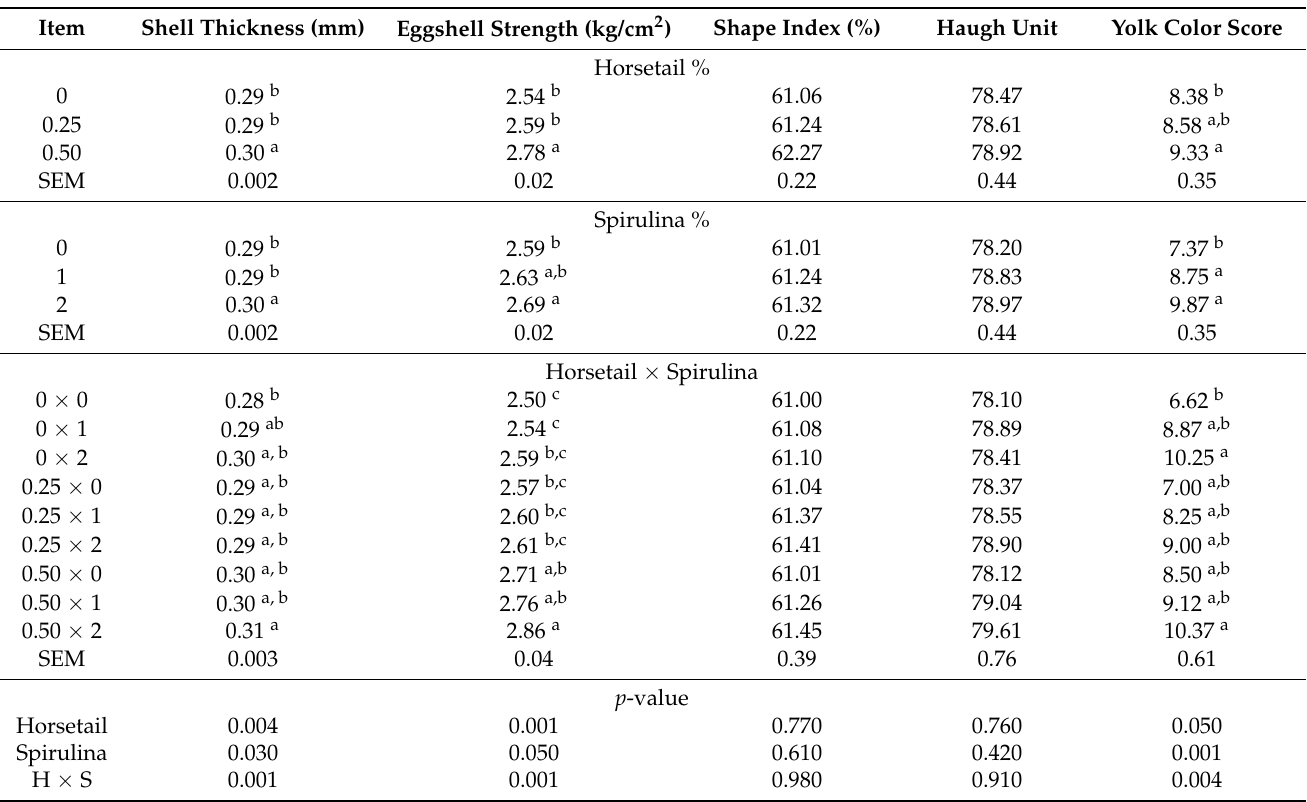
Table 5. Influence of diet on egg qualitative